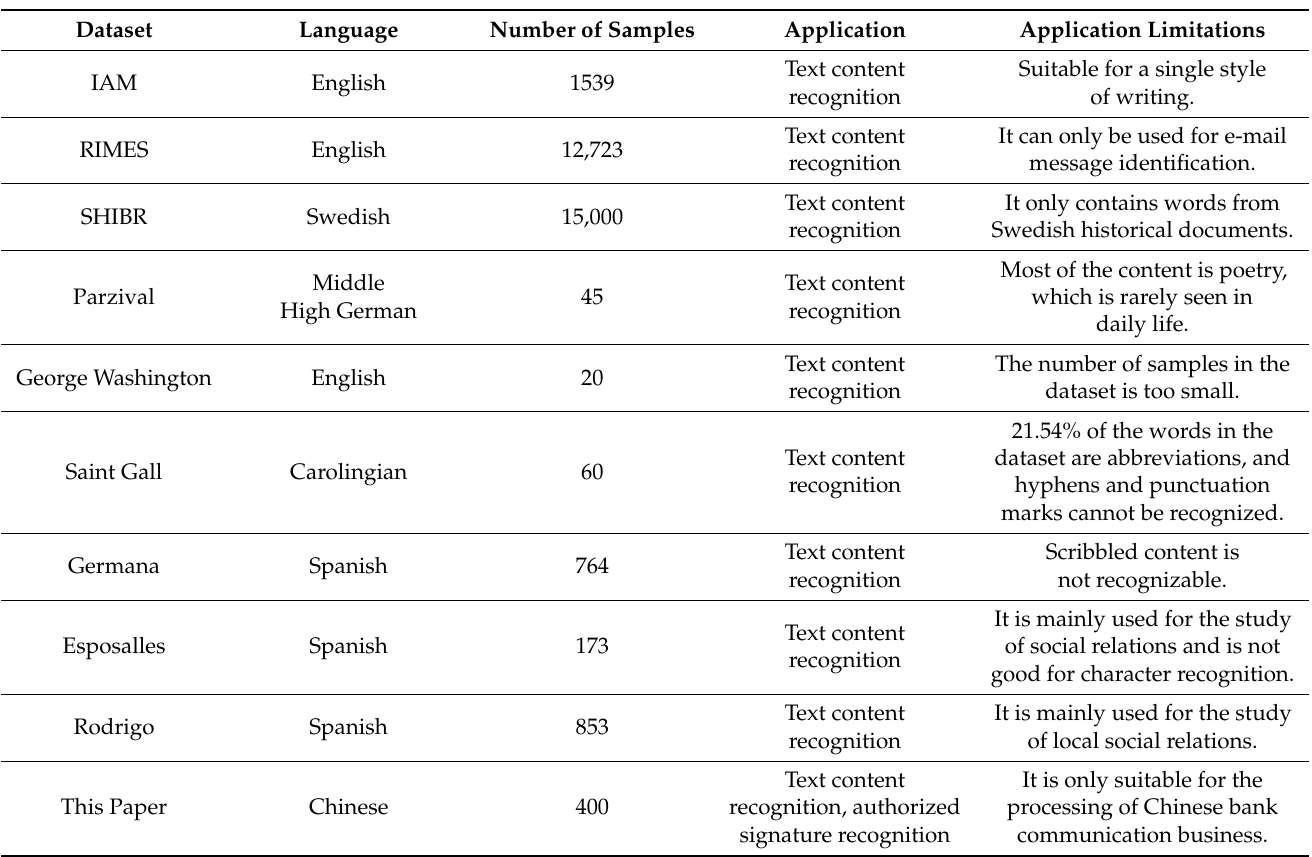
Table 1. Comparison of different